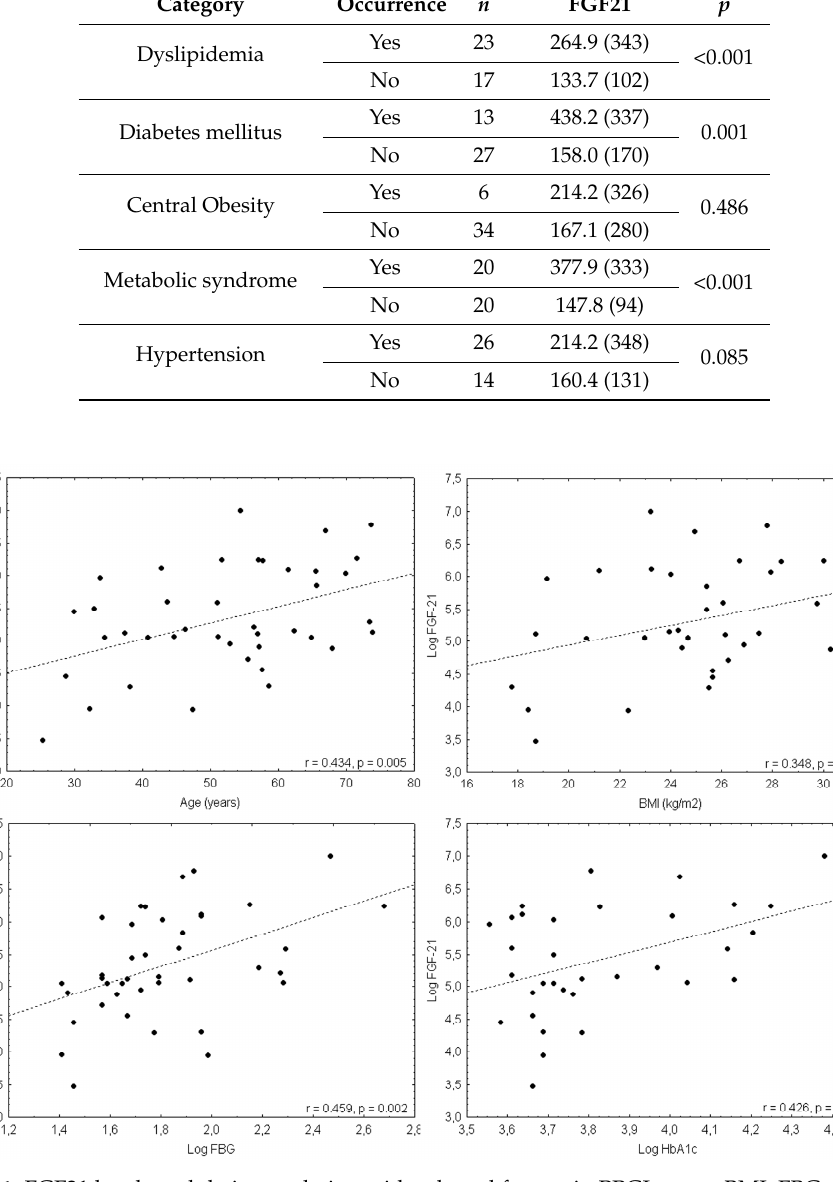
Table 4. FGF21 levels in PPGL patients with metabolic syndrome and its components.